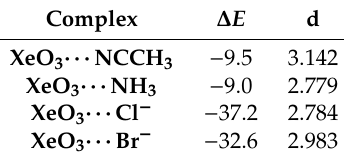
Table 1. Interaction energies and equilibrium distances ( ∆ E in kcal / mol and d in Å) taken from ref. [81].